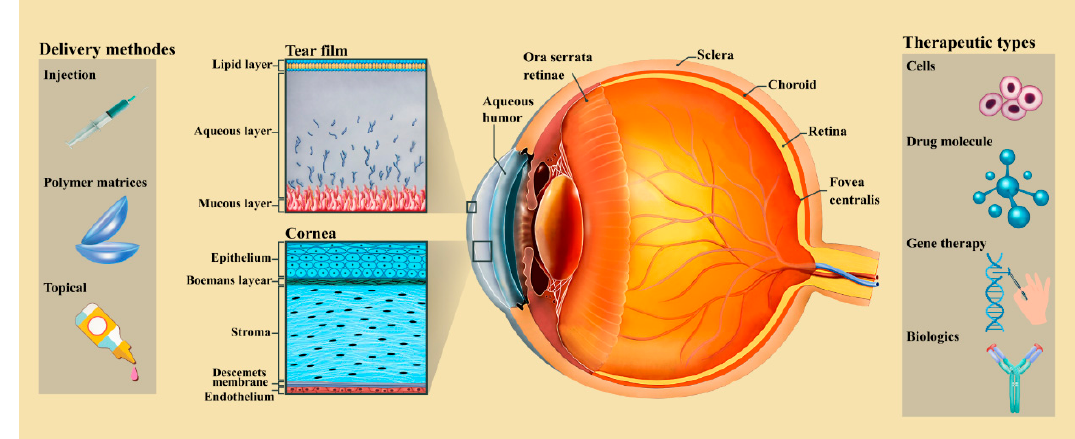
Figure 1. Schematic images of five layer of human cornea structure and overview of categories of cornea drug delivery systems that are adopted to a wide variety of therapeutic agents and their related permeability barriers. These methods include topical administration, drug loaded ocular inserts (for either punctal placement, conjunctival or cornea), and injections through the cornea [1].